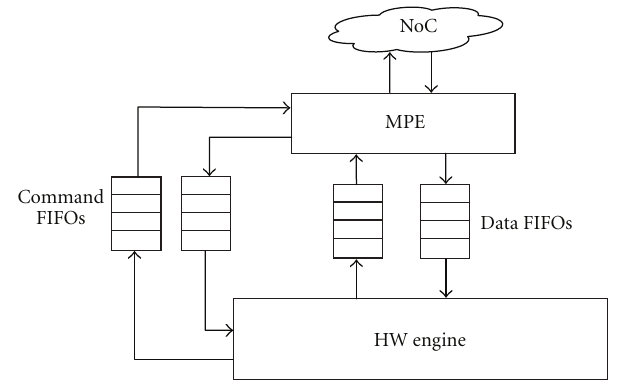
Figure 2: Connection of the application hardware engine and the